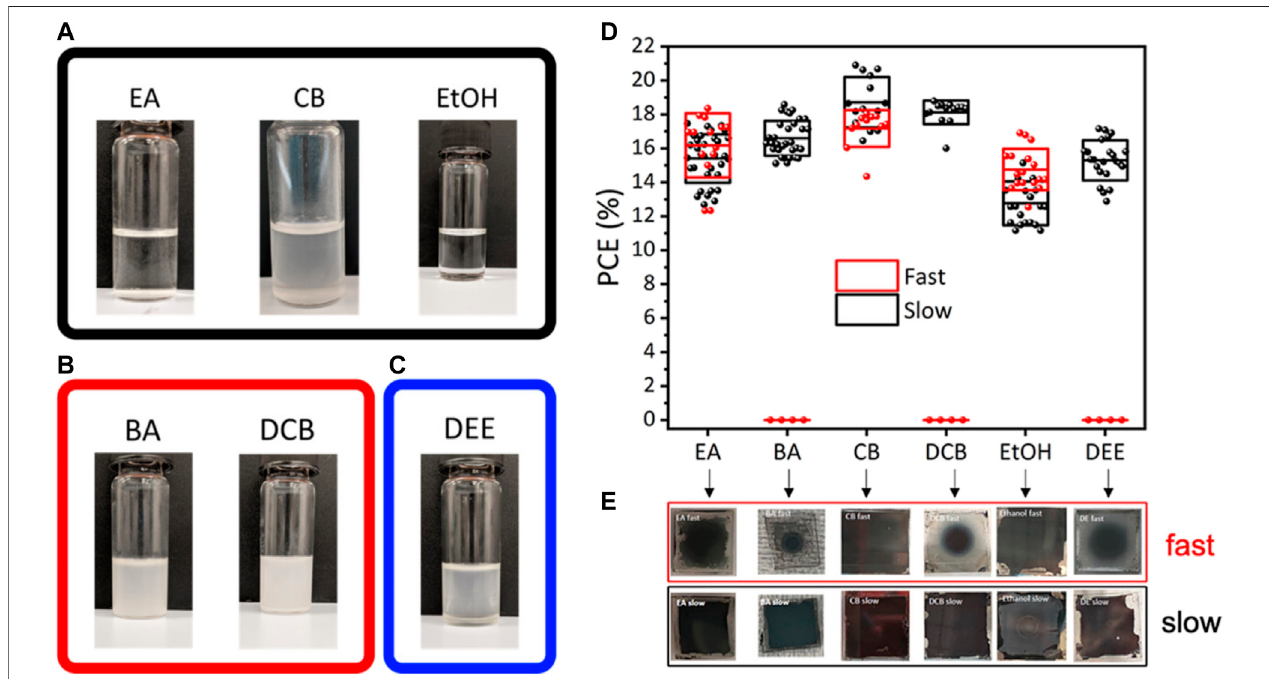
FIGURE 5 | Precipitation tests using the six antisolvents studied in this work. 1 m solutions of CsI + FAI in DMF: DMSO, to which the antisolvent was added and immediately photographed. For (A) ethyl acetate, chlorobenzene, and ethanol, the solution remains clear, whereas for (B) butyl acetate and 1,2-dichlorobenzene, a turbid solution forms instead. (C) DEEforms amostly clear solution; however, aliquid-phaseseparation isobserved, (D) displaysthe effect of theantisolventapplication rate on PCE of the perovskite solar cells, (E) shows the photographic image of the perovskite fi lms with various combinations of antisolvents and antisolvent application rates. Reproduced with permission (An et al., 2021). Copyright 2021,